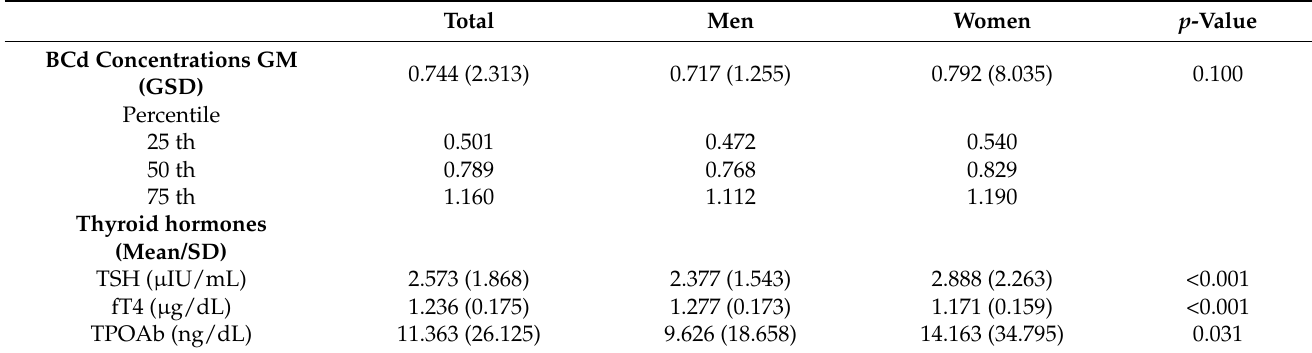
Table 2. Distribution of BCd concentrations ( µ g/L) and thyroid hormones in the study